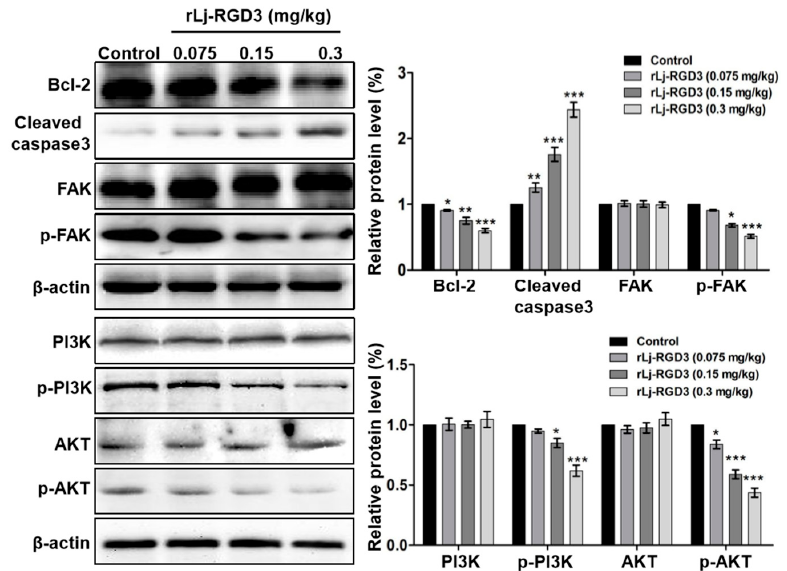
Figure 7. rLj-RGD3 changed the level of Bcl-2, cleaved caspase 3, p-FAK, p-PI3K and p-AKT in the tumors of nude mice bearing HeyA8 xenografts. β -actin was used as a control. Relative to the control group: * p < 0.05; ** p < 0.01; *** p < 0.001.